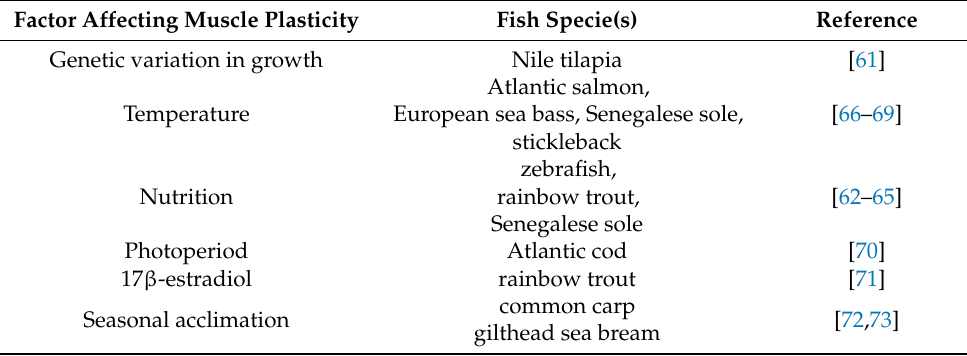
Table 2. Research in fish investigating epigenetic regulation of muscle plasticity. Factor Affecting Muscle